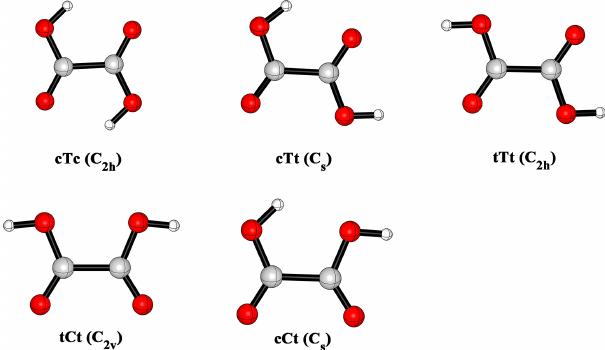
Figure 2. Structures of oxalic acid (OA) conformers optimized at the M06-2X/6-311++G(3df,3pd)